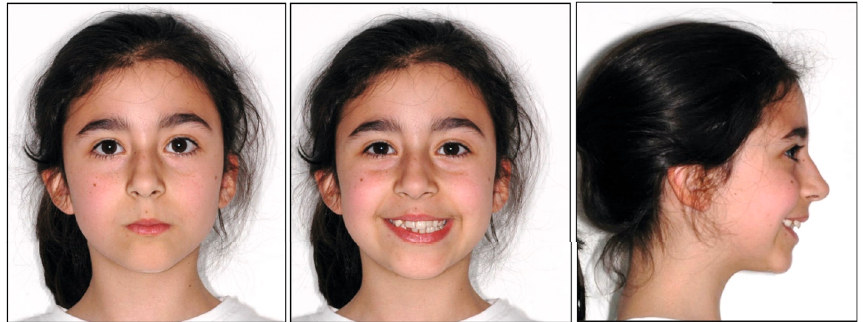
Figure 1: Initial facial photographs.